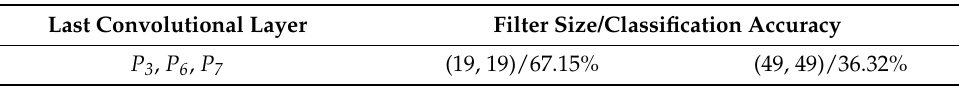
Figure 8. Example of CRM heatmap generated from the fine-tuned classification model built with concatenated features ( P 3 , P 6 , P 7 ) on blurred images. The top row images are input images: left—original unblurred, middle—blurred with (19, 19) filter size, right—blurred with (49, 49) filter size. The bottom row images are heatmaps generated using the left, middle and right images in the top row, respectively. In the heatmap of the original unblurred image, the highlighted area is around the os region, the middle heatmap although visually looks similar with the left one, the highlighted area is off the os region. Table 4. Classification accuracy for different level Gaussian blurred images.